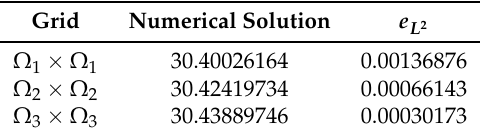
Table 2. Numerical prices and errors on different grids for two-asset option at x = y = 100. Here, u ( x , y , T ) =